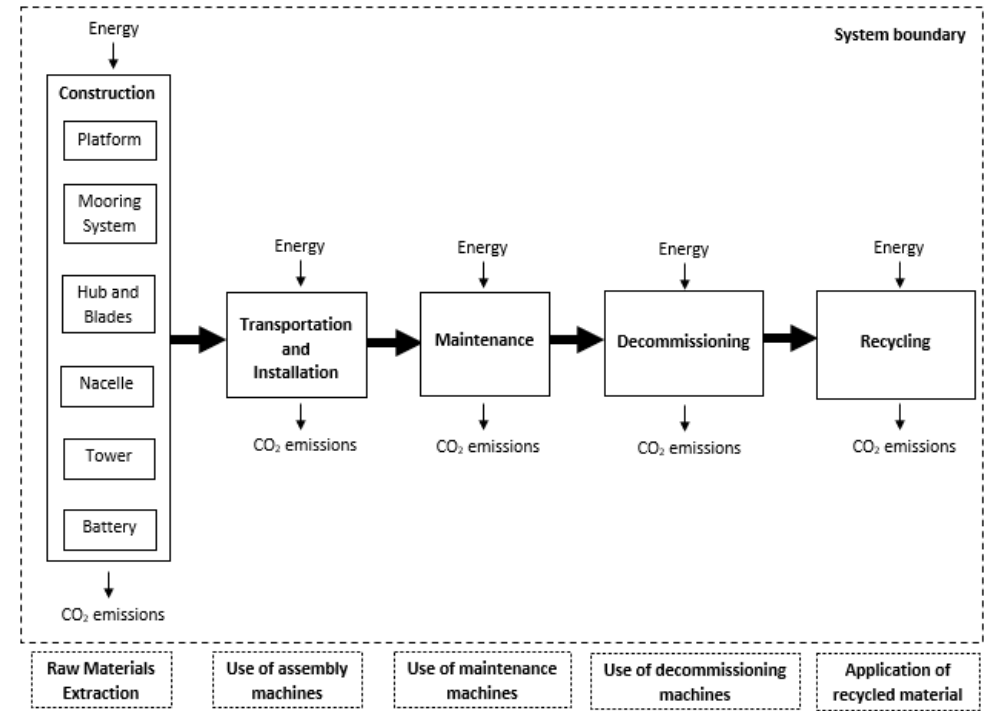
Figure 1. Scheme of the system boundaries considered for the life cycle assessment.